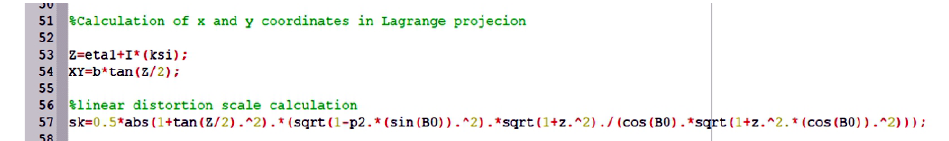
Fig. 6. Calculating the flat rectangular coordinates and the scale of distortions